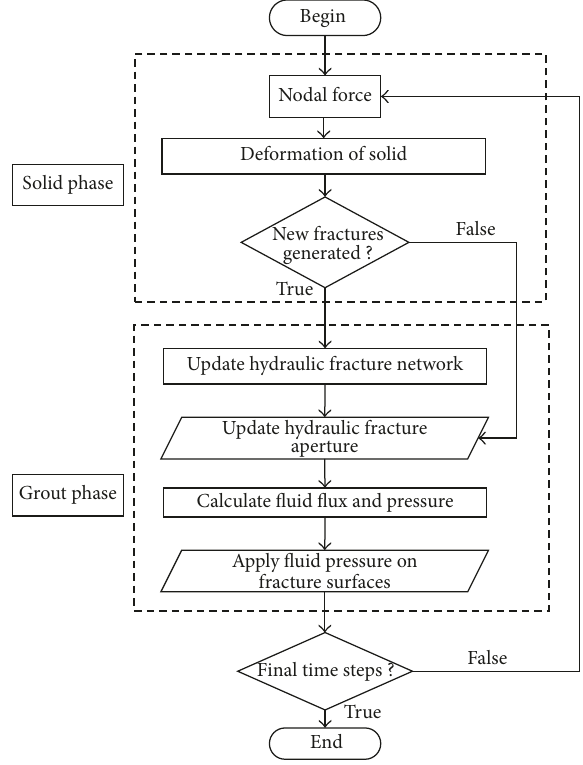
Figure 9: Flowchart of the calculation process in the FDEM-Fluid